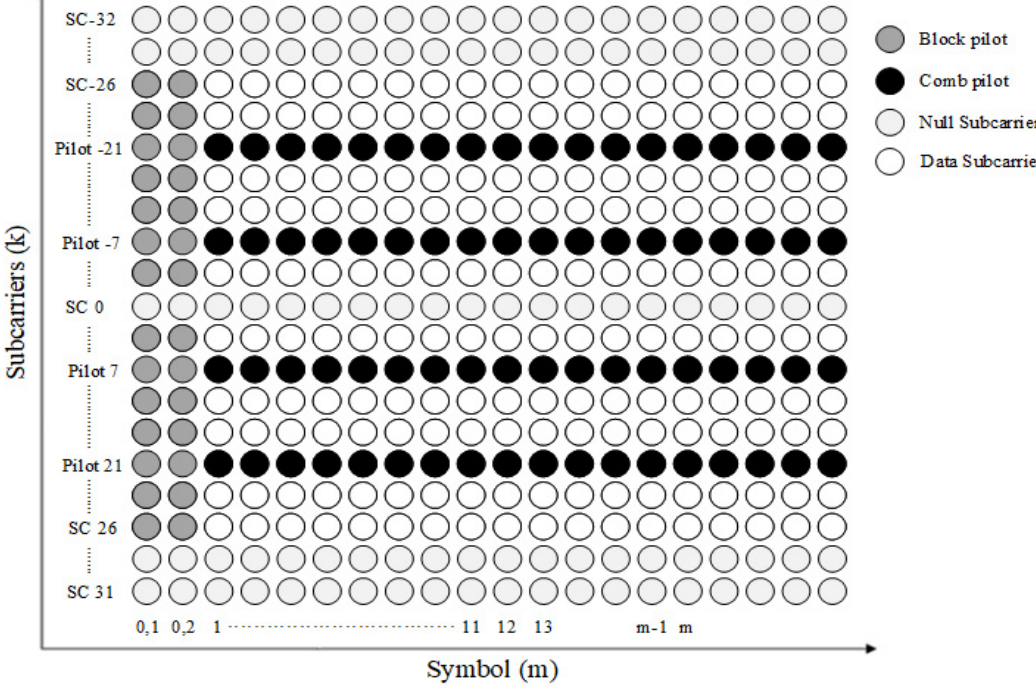
Figure 2. Pilot arrangement of IEEE